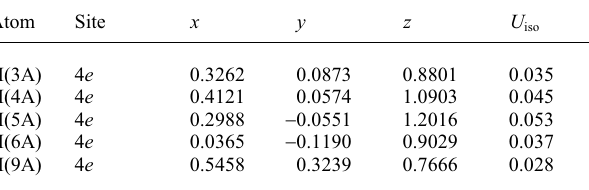
Table 3. Atomic coordinates and displacement parameters (in Å 2 )